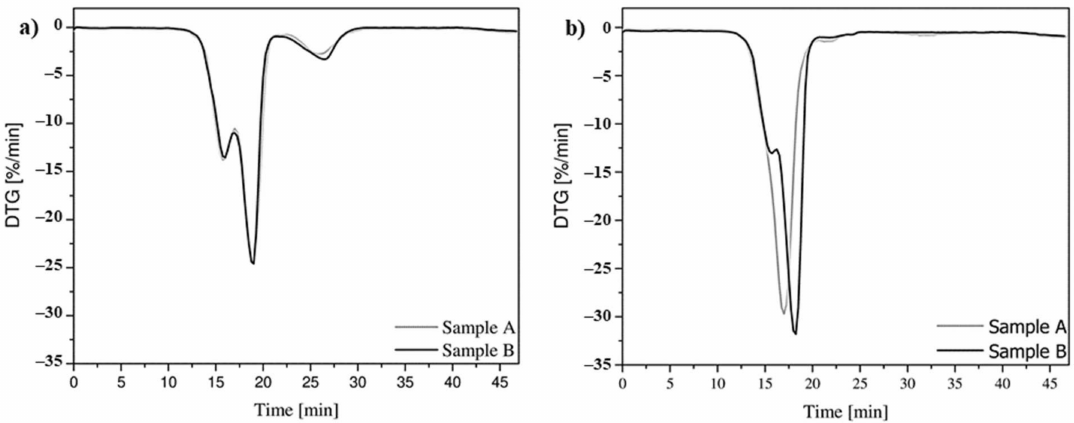
Figure 5. Derivatographic curves made in the atmosphere of a flowing gas: air ( a ) and nitrogen ( b ).